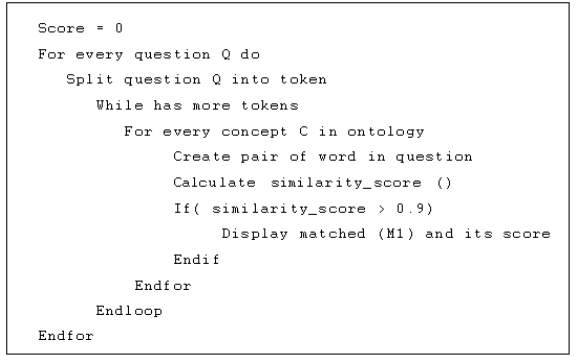
Figure 1. Percentage of Questions with Different Matching Levels